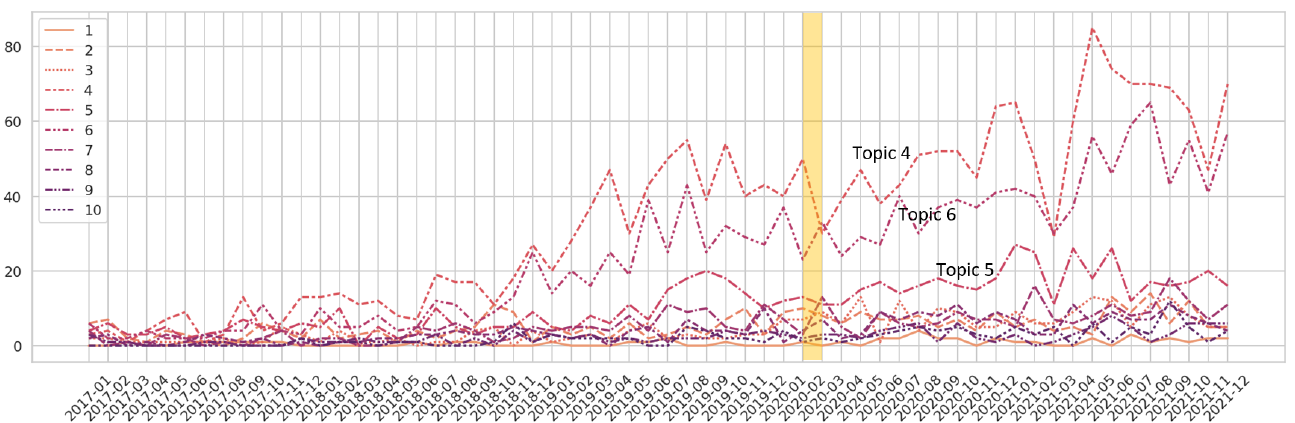
Figure 3. Topics over time showing only 2017 through 2021, although the corpus included low-level response in years prior to 2017. The yellow bar shows when COVID-19 was named by the World Health Organization. Health